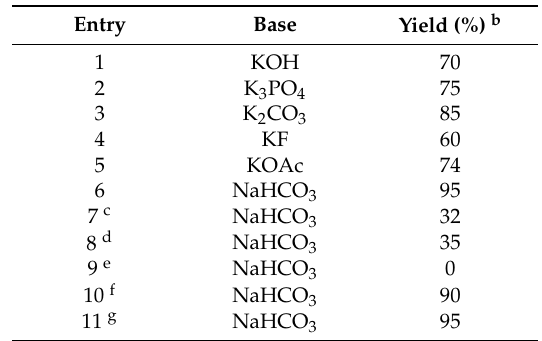
Table 1. Optimization studies for the Pd(NH 3 ) 2 Cl 2 / L -catalyzed Stille coupling of 4 ′ -iodoacetophenone ( 1a ) and PhSnBu 3 ( 2a ) in water a .